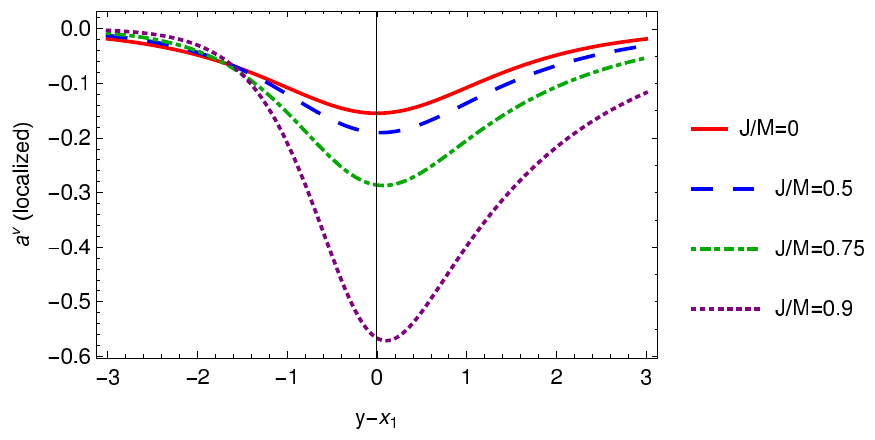
Figure 15 . Opening of the wormhole when interaction is turned on only along the x 1 direction. Temperature (cid:12)xed T = 1 . Set g = 1, (cid:1) = 0 : 6, and we assumed the interaction is turned on 2 (cid:25) between t 0 = 0 and t f =